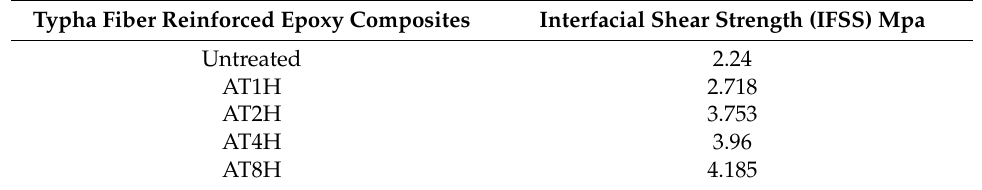
Table 1. Interfacial shear strength of untreated and treated Typha fiber reinforced epoxy composites.